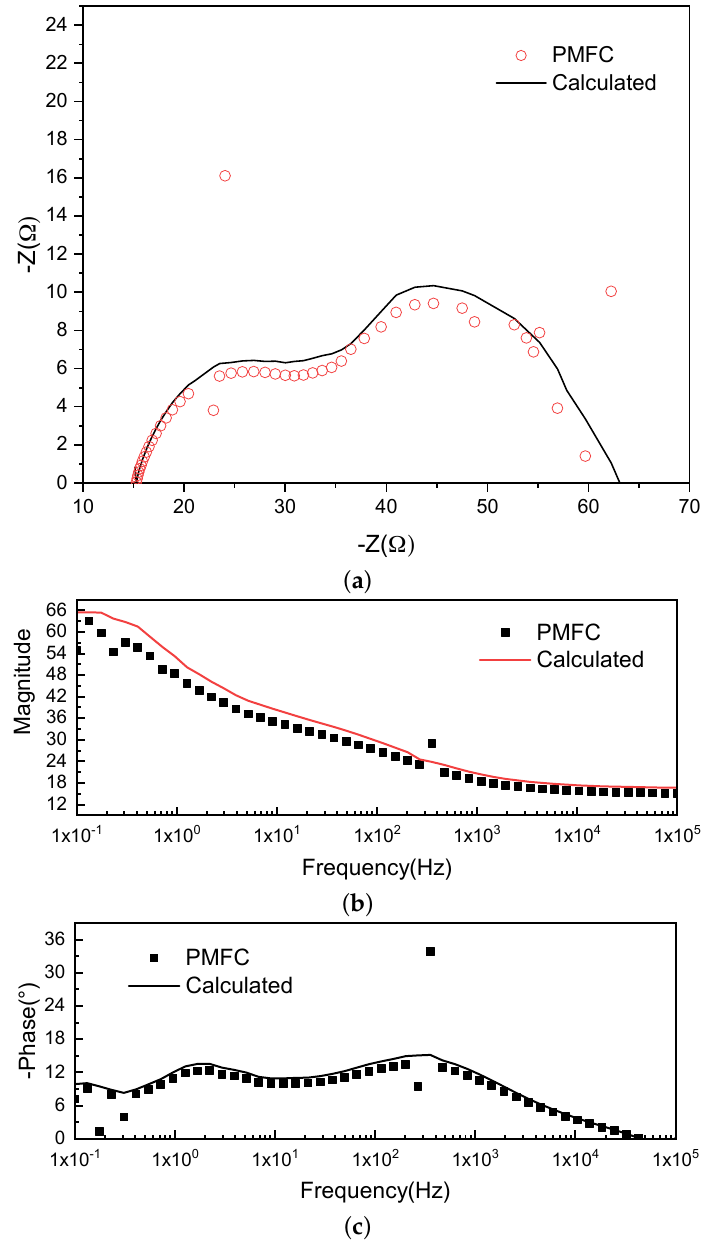
Figure 4. Comparative plots of the PMFC impedance analysis from the experimental and modeled data: ( a ) Nyquist plot of the PMFC array at maximum power point, ( b ) Bode impedance magnitude, and ( c ) impedance